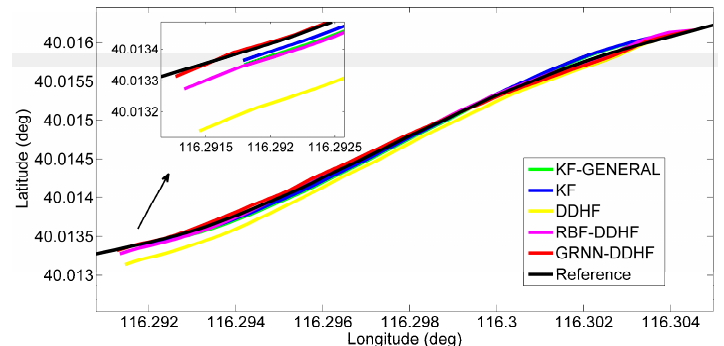
Figure 14. Positioning results during GPS outage 5 in trajectory 2.